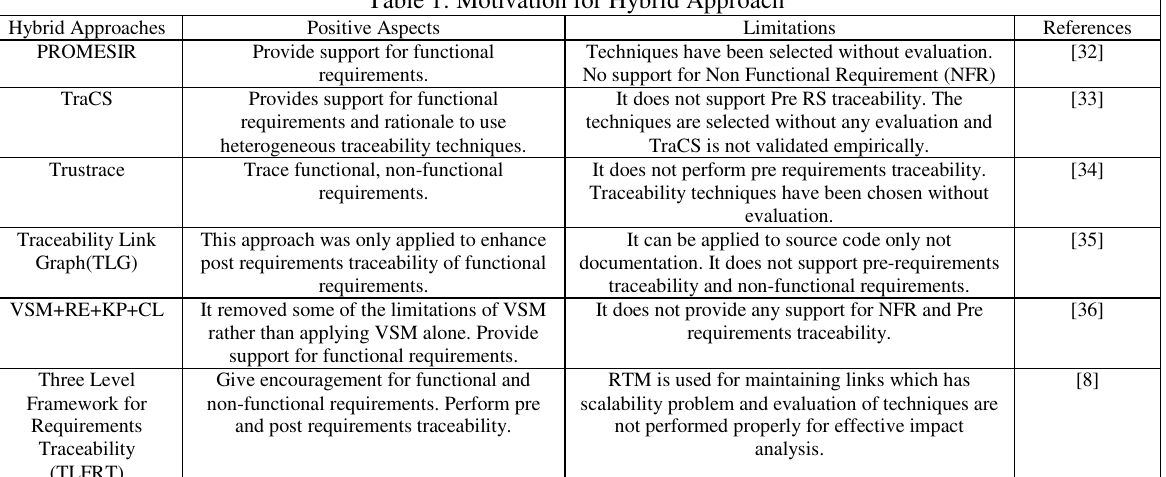
Table 1: Motivation for Hybrid